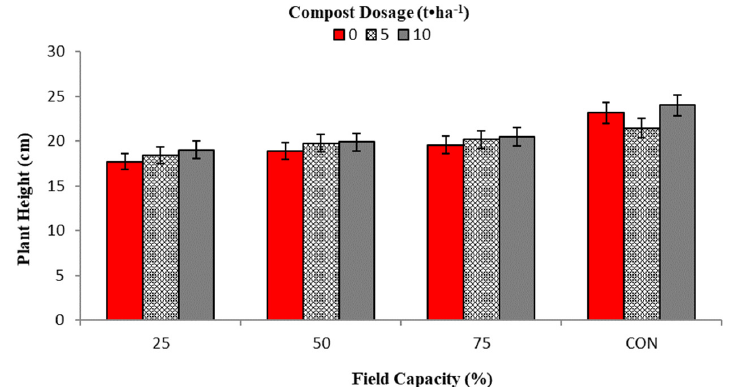
Figure 4. Effect of water deficit and compost dosage on plant height of okra at 4 weeks 0, 5 and 10 represent compost dosage. Data in the interaction analysed with Least Squares Means, and means separated with